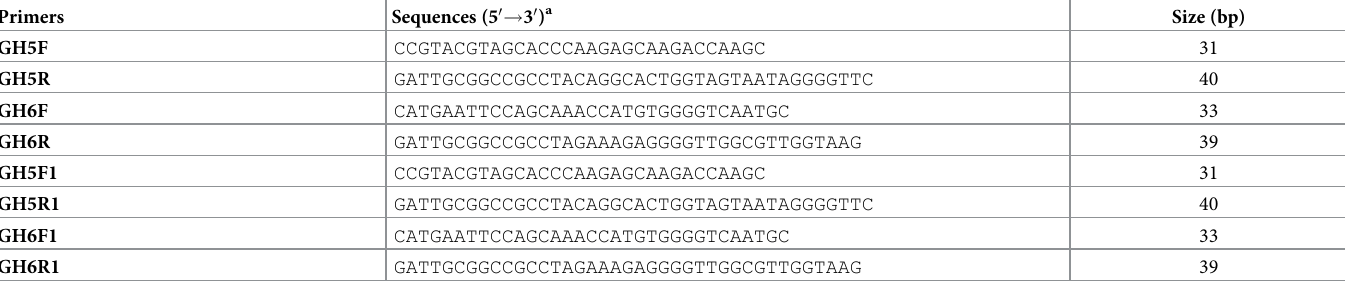
Table 1. Primers used in this